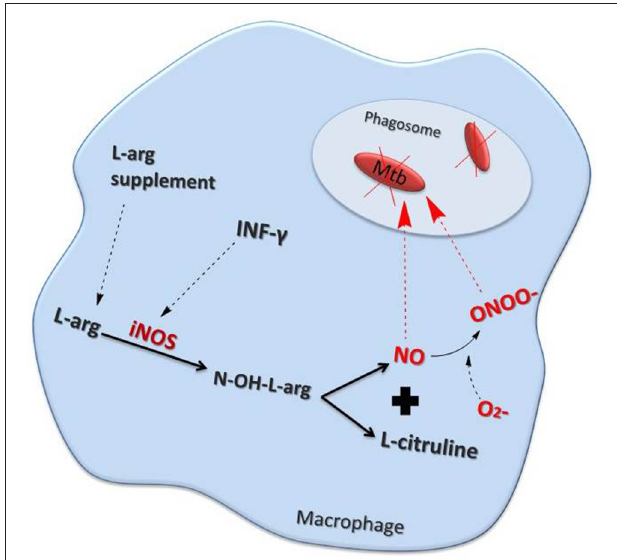
FIGURE 1 | Nitric oxide (NO) production pathway inside a macrophage. Interferon (IFN)- γ as well as other inflammatory stimuli increase NO production by stimulating inducible nitric oxide synthase (iNOS). Elevated levels of the NO precursor, L-arginine (L-arg) also enhances NO production. NO may either